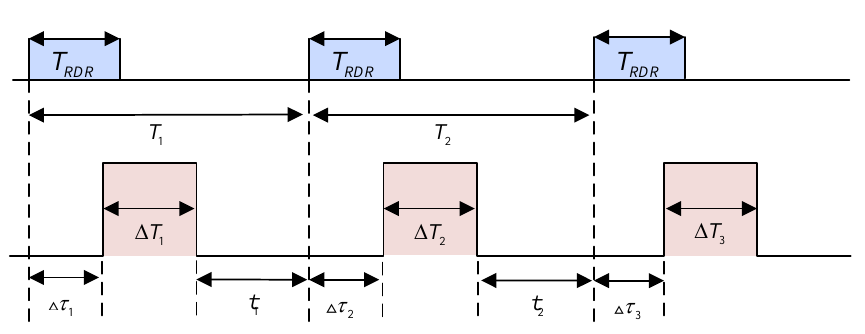
Figure 3. Synchronous aiming jamming timing